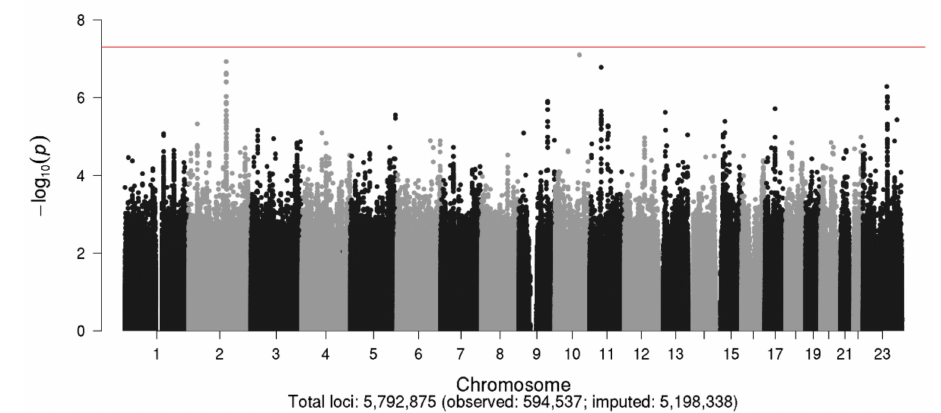
Figure 2. Manhattan plot for the N08Cx study.